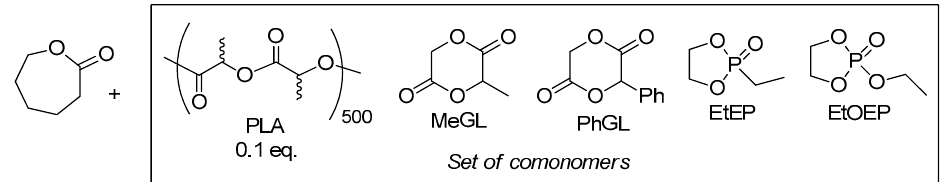
Scheme 7. Comonomers studied in the synthesis of random copolymers with ε CL in the presence